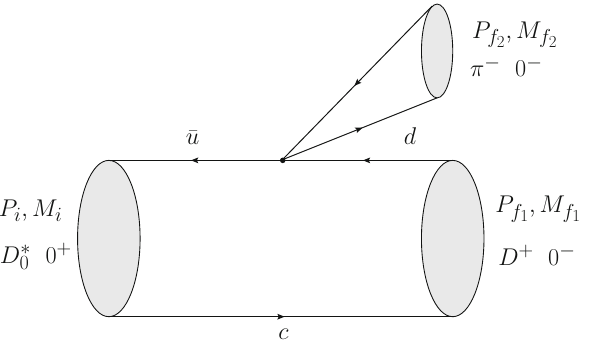
( 2400 ) 0 → D + π − (with the low- 0